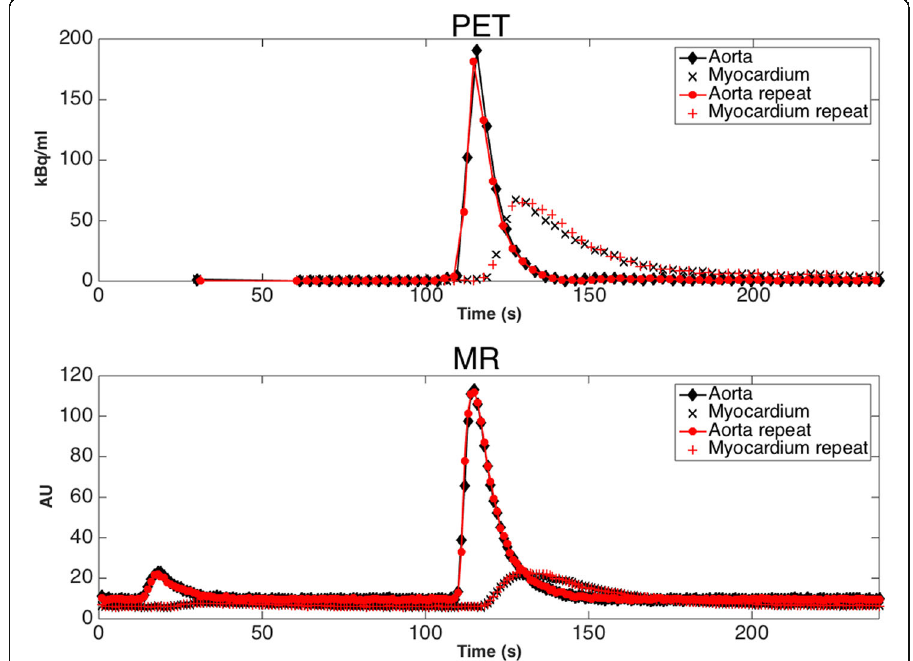
Fig. 4 Comparison of mean activity concentration (kBq/ml) time activity curves (TAC) and mean MR signal (AU) time intensity curves (TIC) acquired from the phantom VOIs (PET-top) and ROIs (MR-bottom). Data are presented for simultaneous PET and MR acquisitions for a myocardial perfusion rate, P T = 4 ml/g/min and cardiac output of 3 L/min. Repeat scan data using ROI and VOI in the same positions are also plotted and show a high level of repeatability. Error bars are omitted in order to improve visual clarity of overlapping